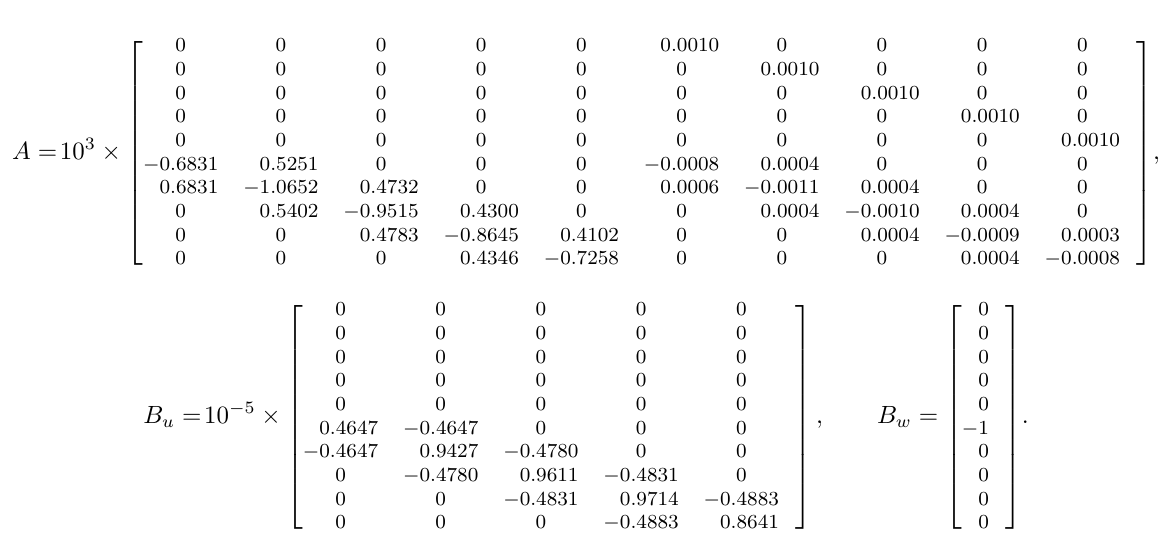
Figure 4: System matrices of the first-order model with interstory drifts and interstory velocities as state